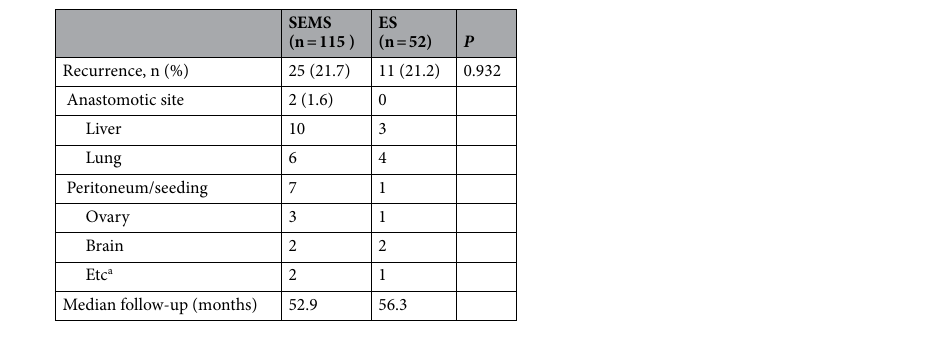
Table 5. Distribution of tumor recurrence in obstructive colorectal cancer. Data are presented as the number of patients (%) or median unless otherwise stated. SEMS self-expandable metallic stent, ES emergent surgery, n number. a Etc included Right renal vein, rectovaginal pouch, and bladder